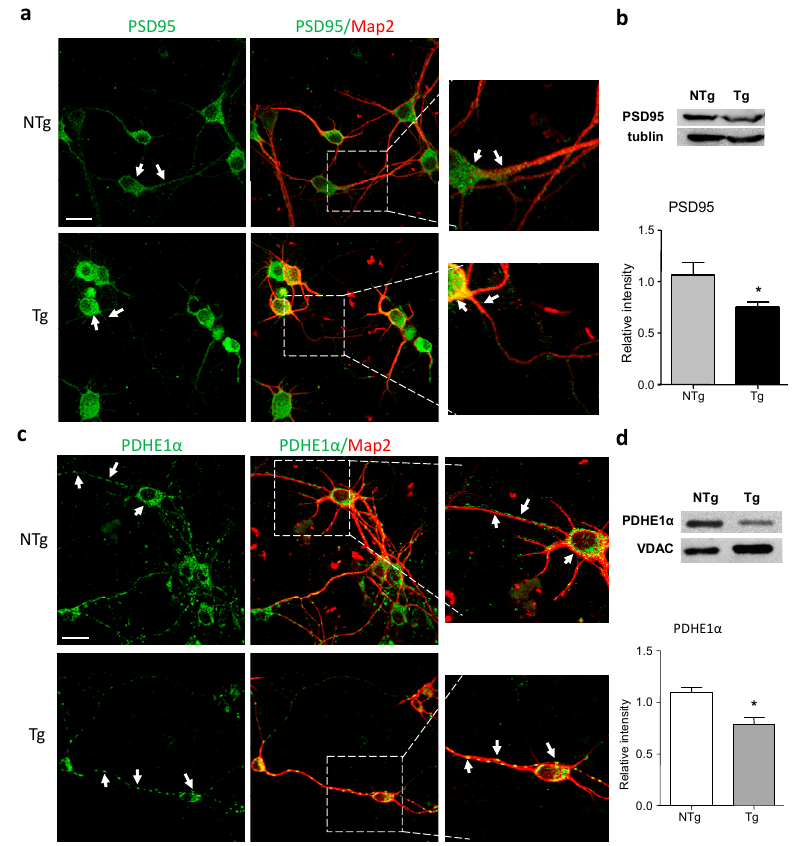
Figure 2. Altered expressions of synaptic and mitochondrial proteins in 3× Tg-AD neurons. Areas boxed in a and c are shown at higher magnification in the right panels, respectively. ( a ) Double-labeling analysis of neuronal marker MAP2 with post synaptic density protein 95 (PSD95) in neurons from NTg and Tg neurons. PSD95 expression was weaker in the neurites of Tg cells as compared to NTg group and restricted to the soma (white arrows); ( b ) Western blot assay demonstrated that the level of PSD95 was lower in Tg neurons; ( c ) Double-labeling analysis of MAP2 with pyruvate dehydrogenase-E1 α (PDHE1 α ) in neurons from NTg and Tg neurons. PDHE1 α expression was more evenly distributed in NTg cells whereas Tg cells showed fragmented expression of PDHE1 α along the neuronal processes (white arrows); ( d ) Western blot assay demonstrated that the level of PDHE1 α was lower in Tg neurons. Voltage-dependent anion-selective channel protein (VDAC) was used as a mitochondrial loading control. Bars graph (means ± SD) represented three independent experiments. * p < 0.05. Scale bars in ( a , c ) = 20 μ m.